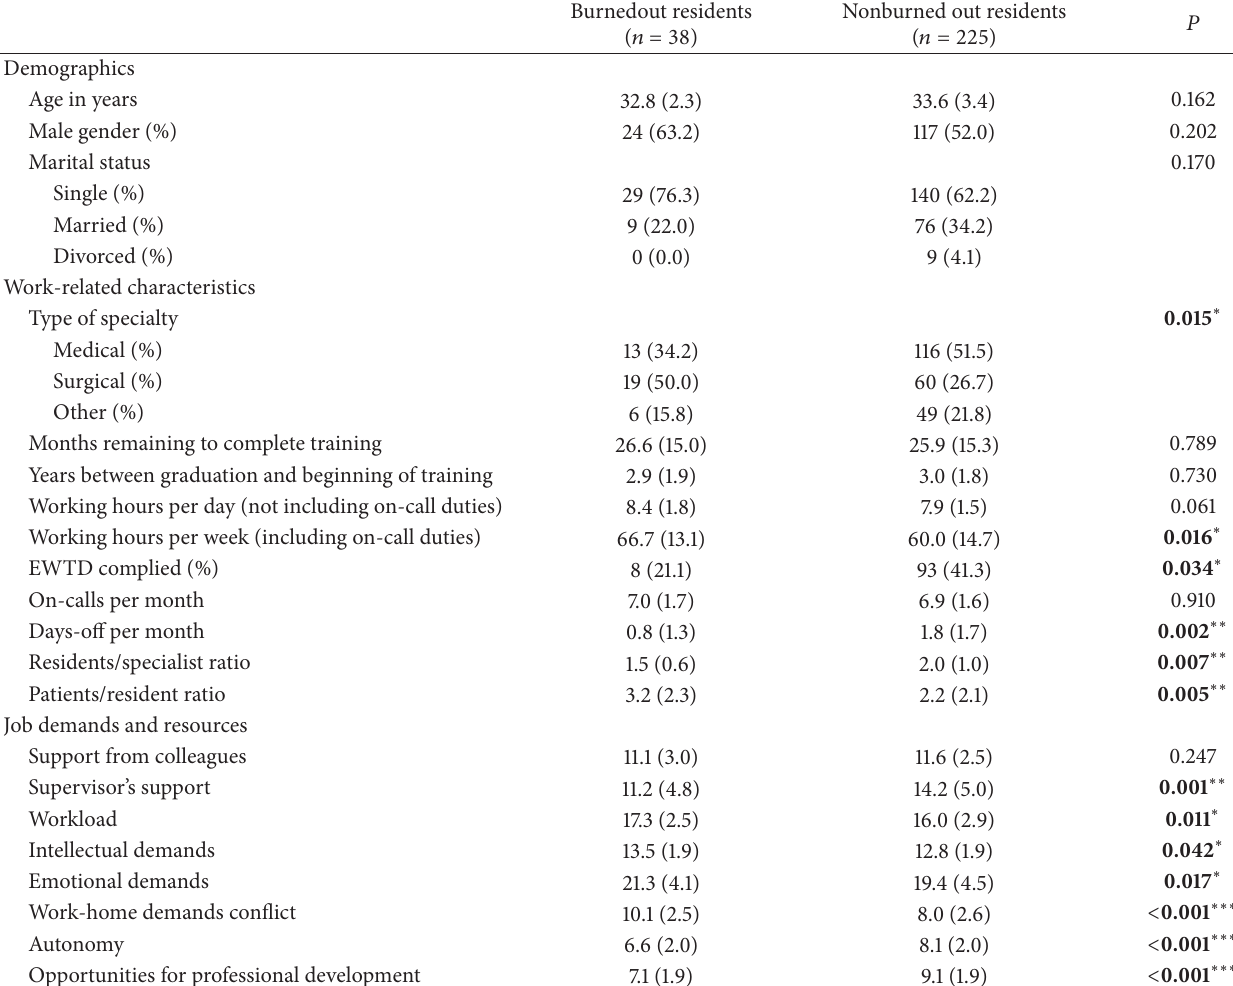
Table 3: Characteristics of “burned out” and “nonburned out” residents.